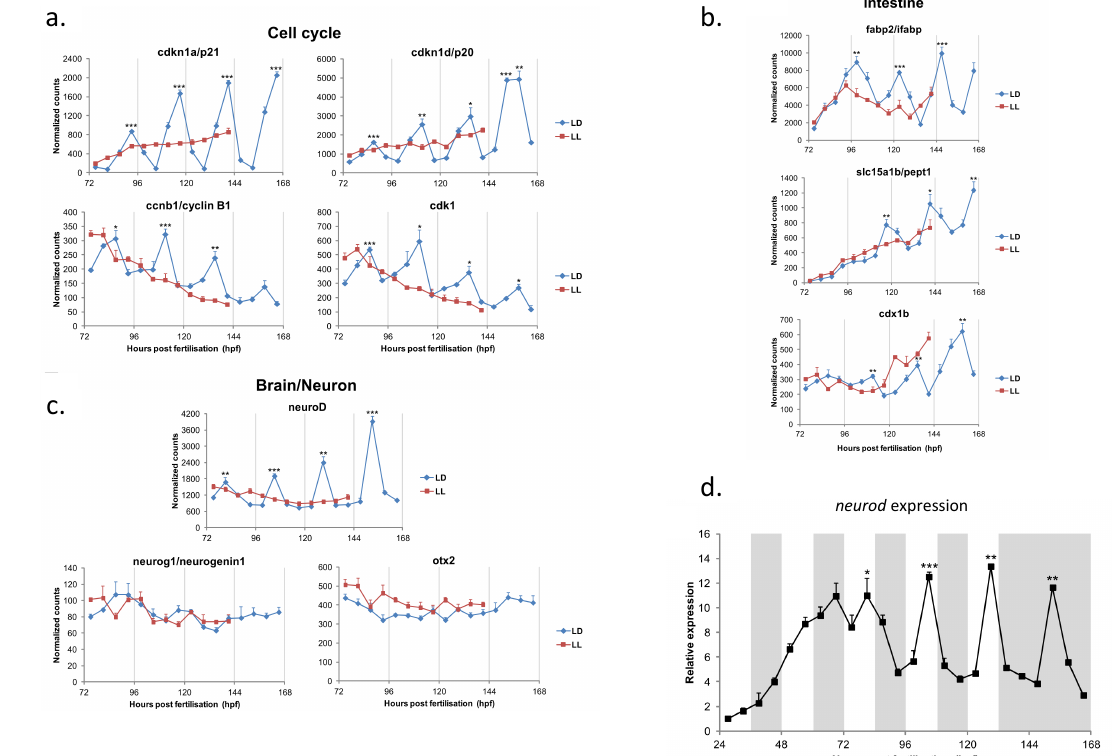
Figure 2. A selection of rhythmic clock-target genes regulated in the early stages of zebrafish larval development. A Nanostring-based gene expression analysis of a wide selection of genes examined between 72–168 h post-fertilization. The selected data shown in panels a, b and c reveals a wide range of genes that show robust oscillations during embryo development, when larvae are raised on a light-dark cycle. Constant light (in red) stops the circadian pacemaker in the embryo, as well as the rhythmic expression in downstream, clock-regulated genes. ( a ) shows that numerous cell cycle regulators have robust transcriptional daily rhythms. ( b ) shows changes in three genes involved in neuro-development and differentiation, with neuroD showing very high amplitude rhtyhms. ( c ) shows rhythms in three genes involved in cell fate decisions in the intestine. ( d ) shows how neuroD only begins to show robust oscillations from day 4–5 of development onwards. (Taken from Laranjeiro and Whitmore, 2014)